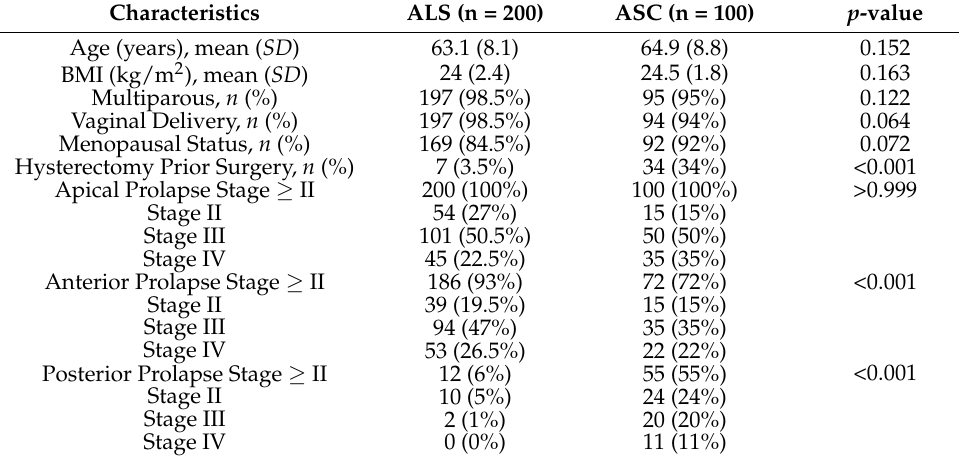
Table 1. Pre-operative demographic characteristics. Data are presented as n (%) or as median values ± SD. Characteristics comparing ALS vs. ASC before surgery were statistically analyzed with two-tailed Fisher’s exact test or by two-tailed Mann–Whitney test, accordingly. p -values < 0.05 were considered statistically significant. ALS: abdominal lateral suspension; ASC: abdominal sacral